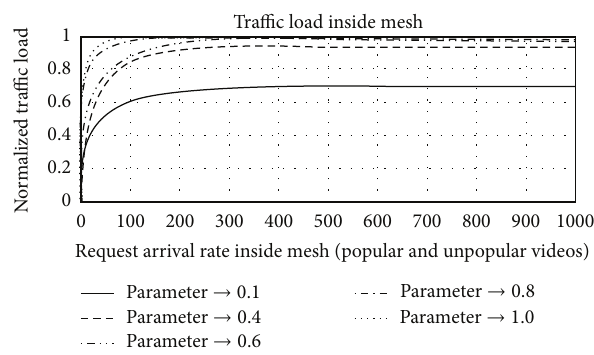
Figure 13: Normalized traffic load in interactive session (higher range of